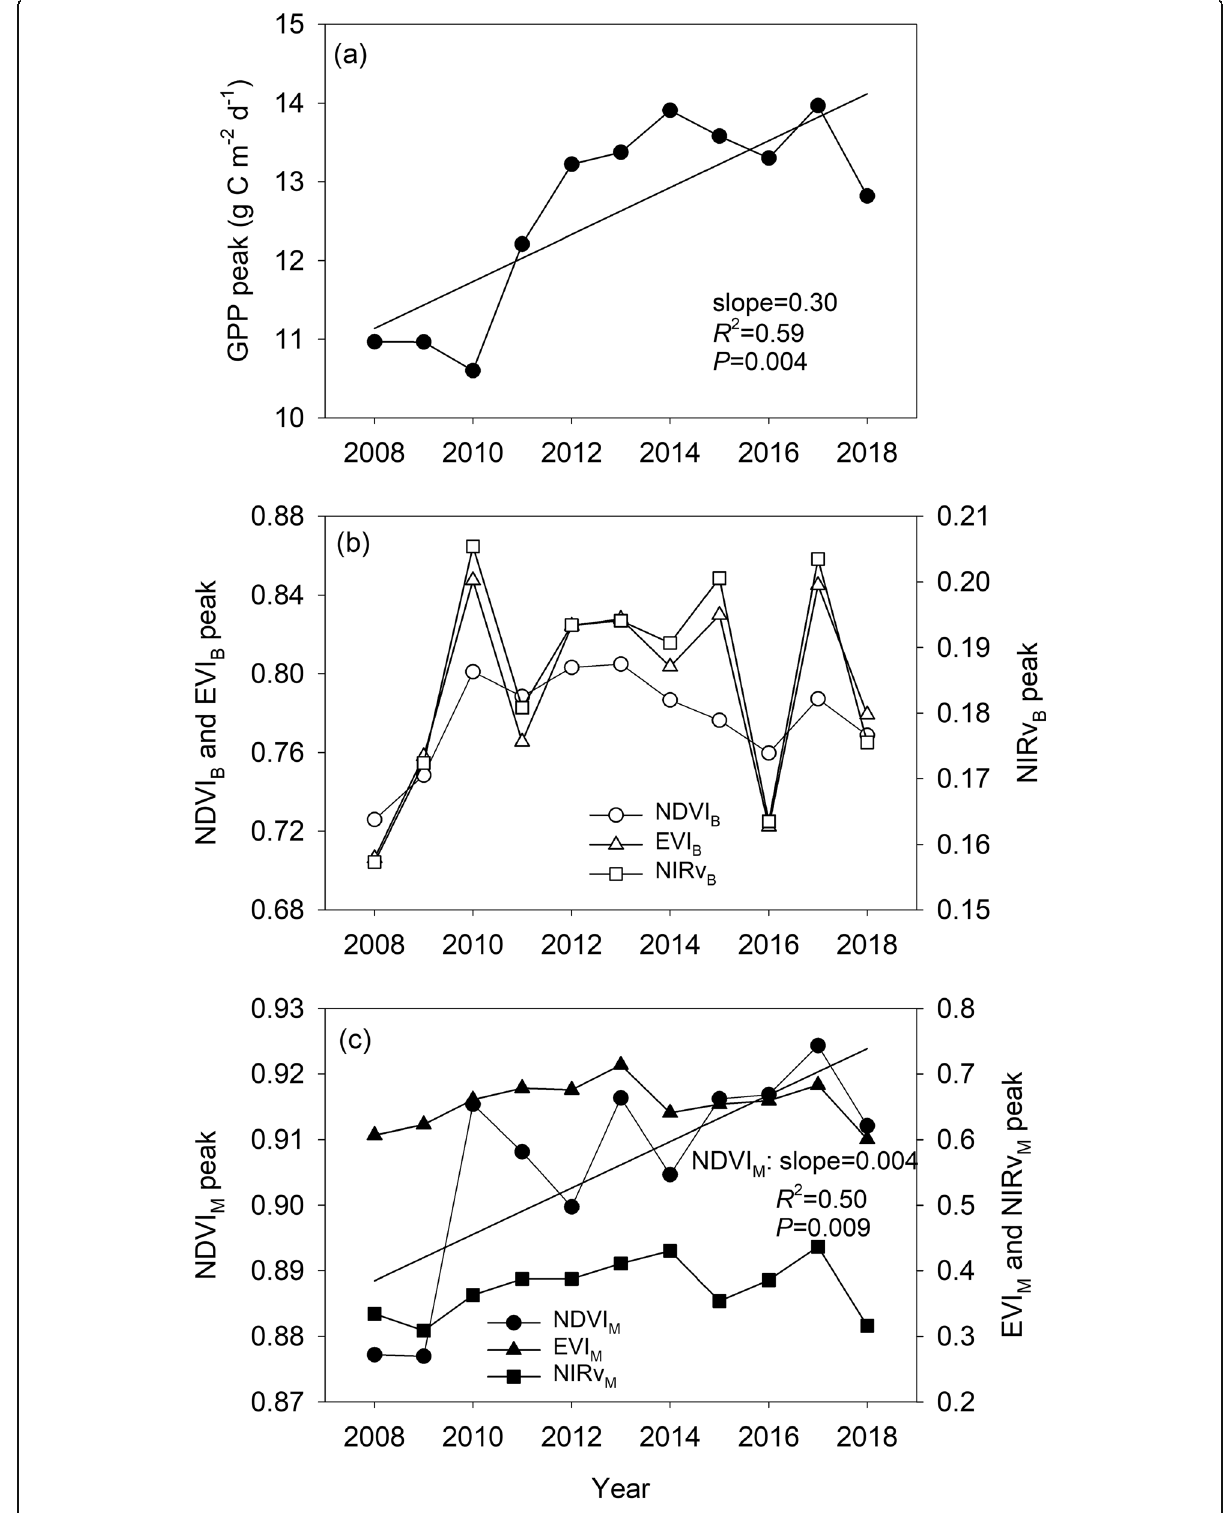
Fig. 6 Interannual variation in the summer peaks of gross primary production (GPP) and vegetation indices. NDVI B : broadband normalized difference vegetation index, EVI B : broadband enhanced vegetation index, NIRv B : broadband near-infrared albedo of vegetation, NDVI M : MODIS normalized difference vegetation index, EVI M : MODIS enhanced vegetation index, NIRv M : MODIS near-infrared reflectance of